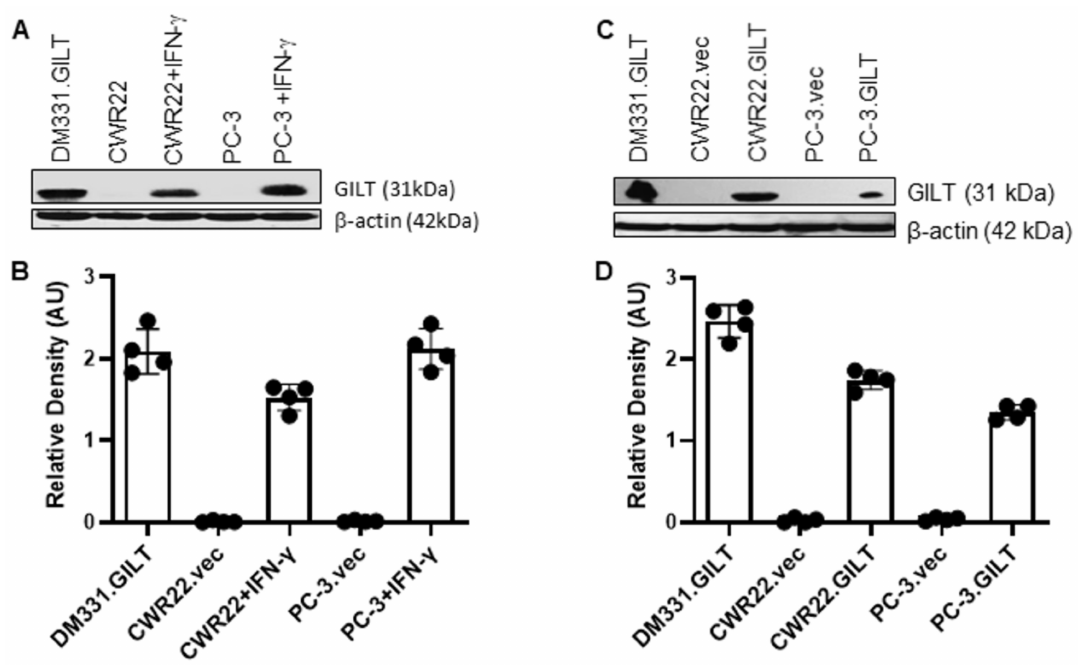
Figure 1. Induction of GILT in human prostate cancer cells by treatment with IFN- γ and insertion of GILT in prostate cancer cells with GILT cDNA. ( A ) Human prostate cancer cell lines CWR22Rv1 and PC-3 were treated with IFN- γ for three days, followed by washing and Western blot analysis for